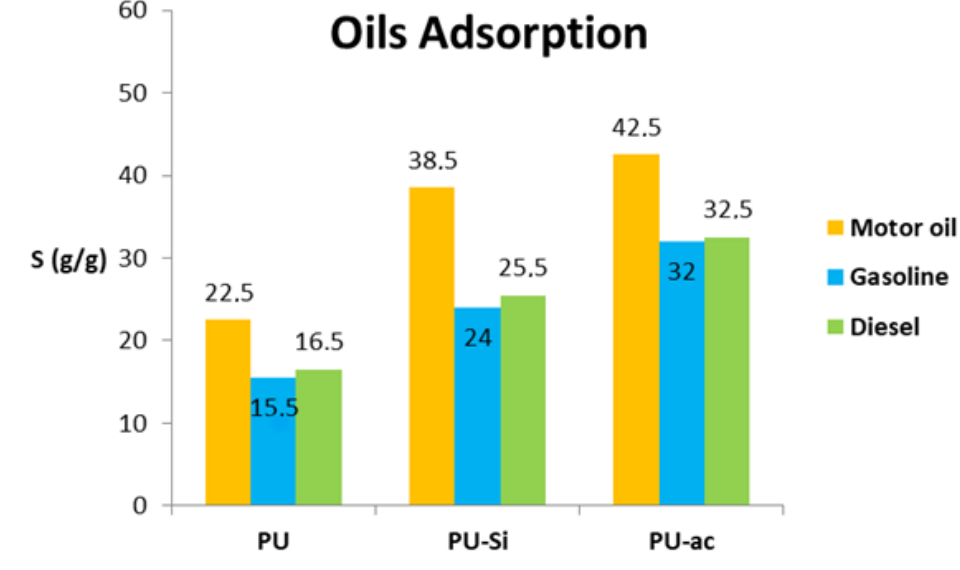
Figure 5. Oil adsorption capacity, S, respect to different types of